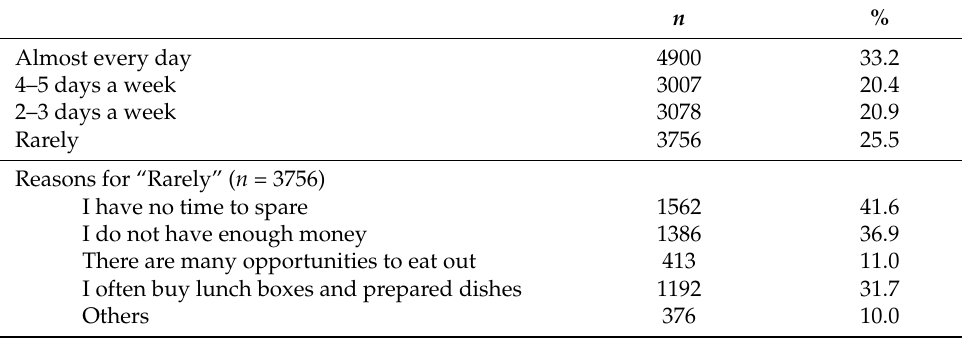
Table 1. Frequency of a well-balanced diet and reasons for its